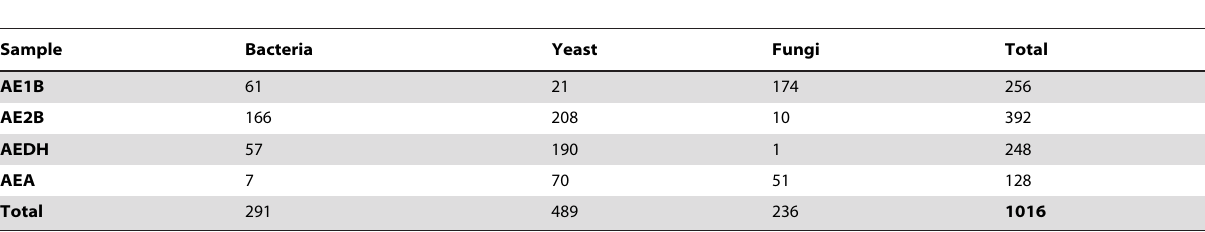
Table 2. Distribution of types of lipolytic microorganisms isolated from the oil mill samples.